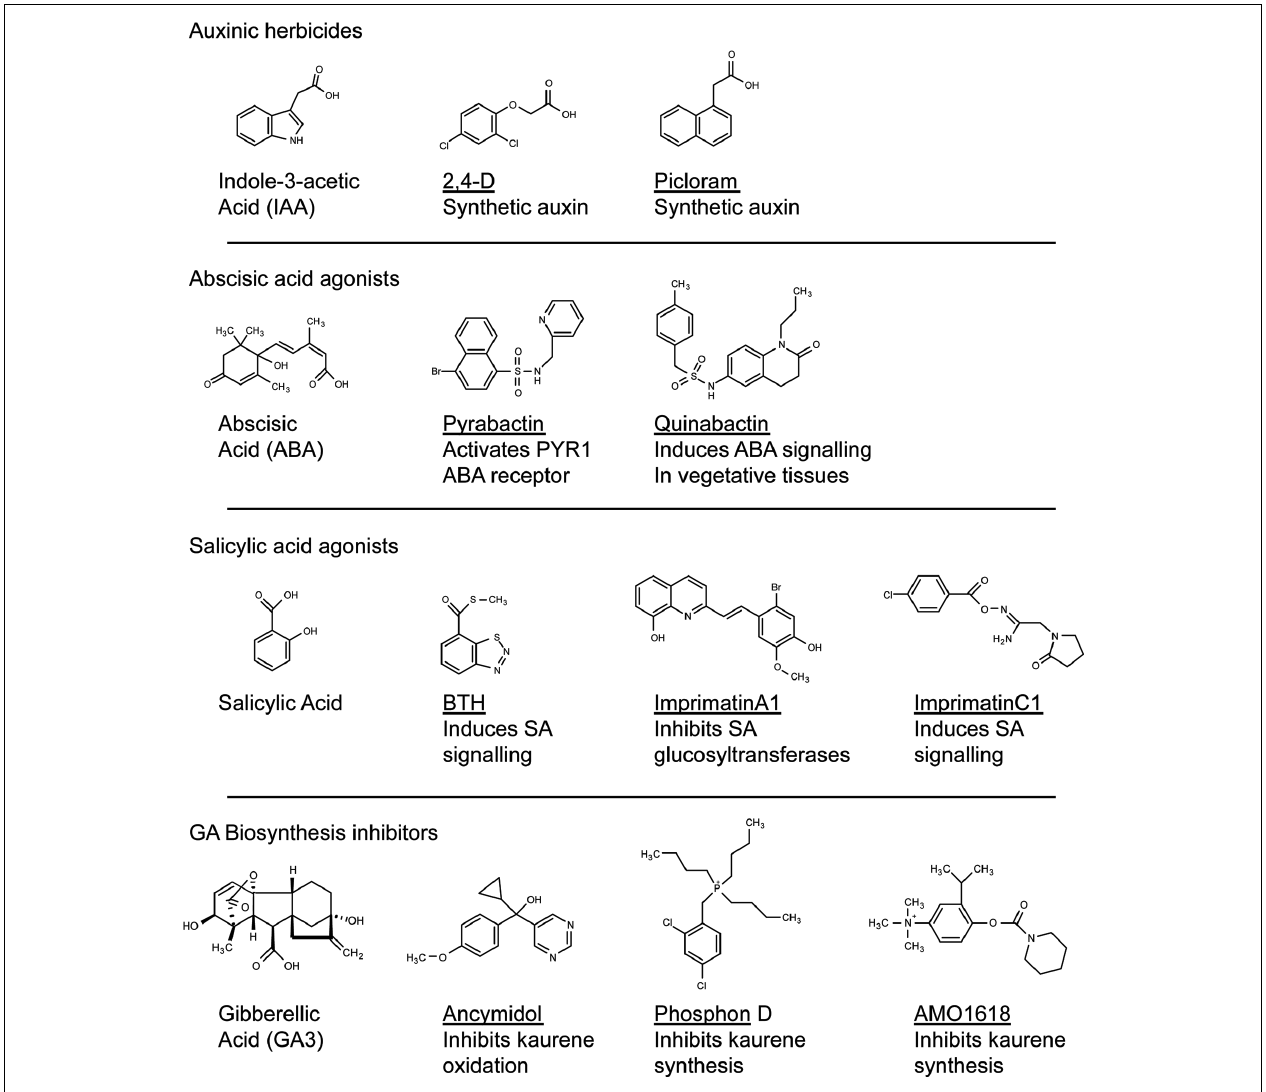
FIGURE 1 | Structural diversity of compounds that modify plant hormone signaling. Compounds that modulate hormone signaling have been identified for major plant hormones. By targeting perception or metabolism, these compounds can induce or inhibit hormone activity. High-throughput screening